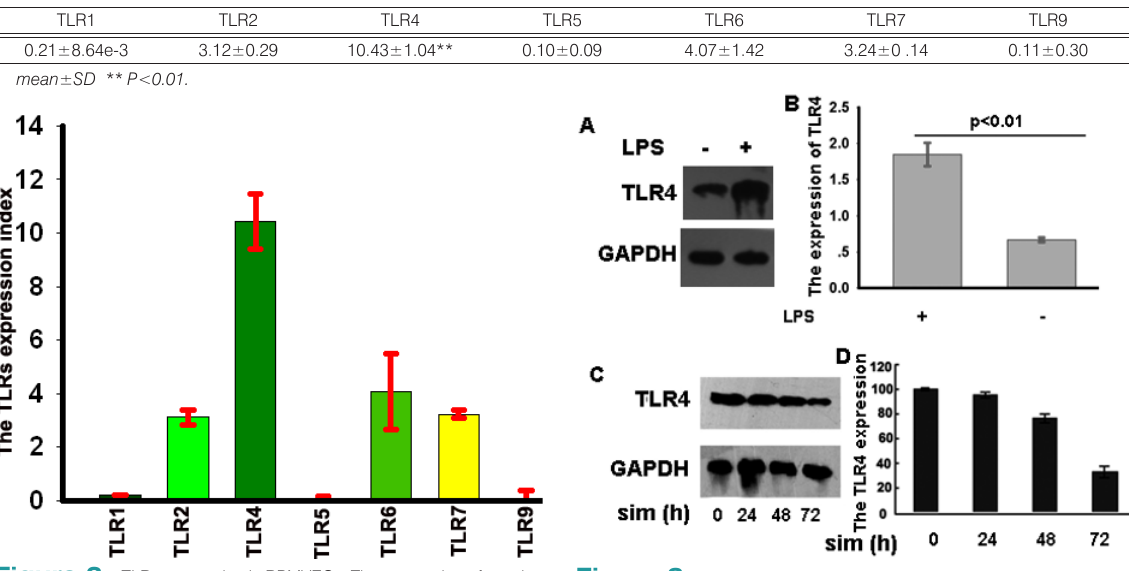
Figure 3. Simvastatin suppresses the LPS-induced TLR4 expression.